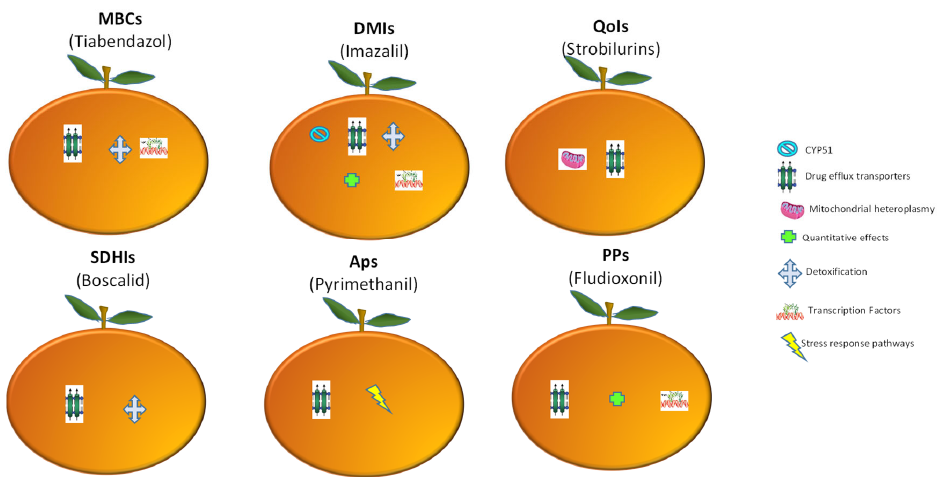
Figure 6. Mechanisms of resistance to main types of fungicides used for green mold disease management. Each orange represents a chemical class, whereas the cryptograms within the oranges correspond to a resistance process as shown in the figure. MBCs: methyl benzimidazole carbamates, DMIs: demethylation inhibitors; QoIs: quinone outside inhibitors; SDHIs: succinate dehydrogenase inhibitors; APs: anilinopyrimidines; PPs: phenylpyrroles. Adapted from Hu and Chen [105].